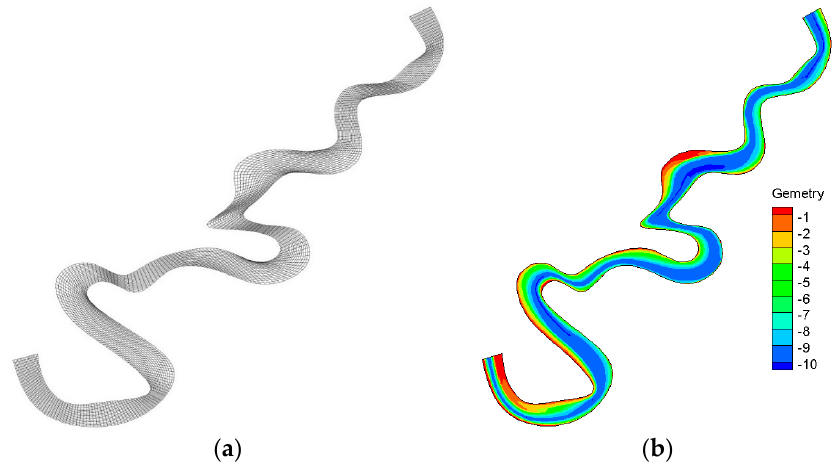
Figure 4. Study area mesh ( a ) and the bathymetry data of the river stretch ( b ).